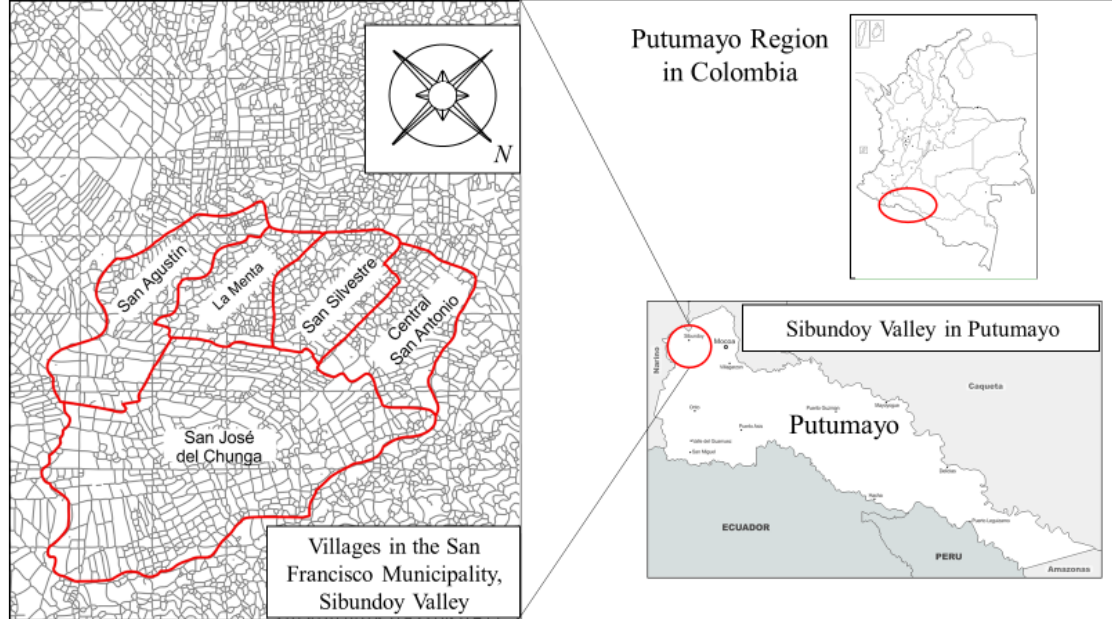
Figure 1. San Francisco municipality, Sibundoy Valley, Colombia.